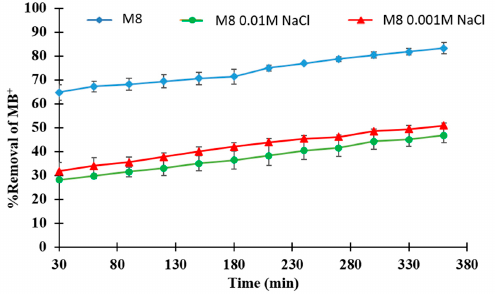
Figure 13. E ff ect of salty dye solutions (0.001 and 0.01 M NaCl) on the removal process for M8 membrane.